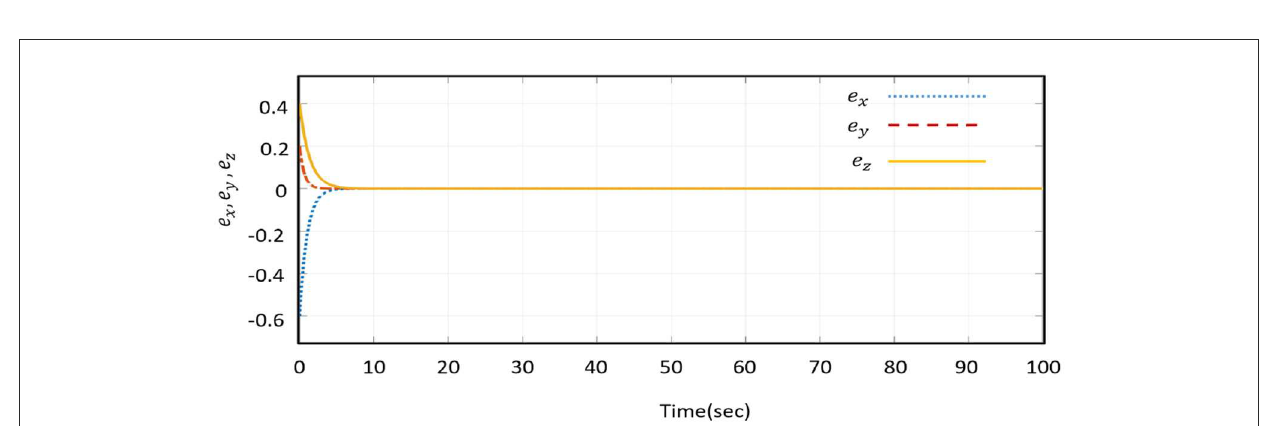
FIGURE5 Shown are the error states ( e x , e y , e z ) after synchronization in dynamical